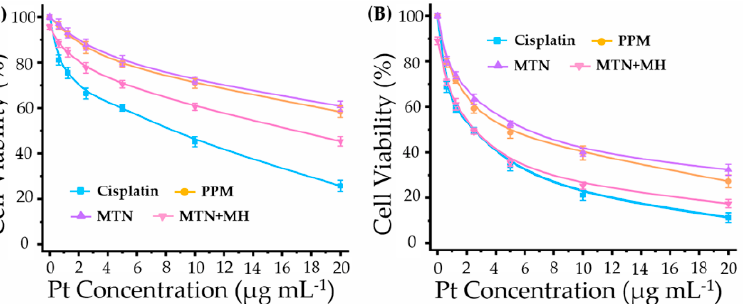
Figure 6. The cytotoxicity of 4T1 treated with cisplatin, PPM, MTN, and MTN + MH (duration time of MH: 20 min per 24 h) for 24 h ( A ) and 48 h ( B ). of MH: 20 min per 24 h) for 24 h ( A ) and 48 h ( B